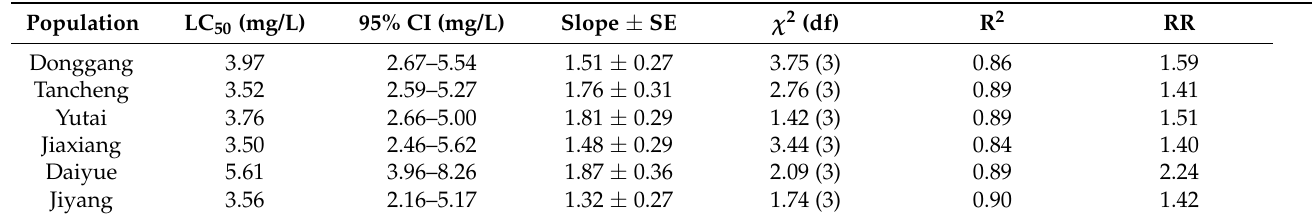
Table 8. Sensitivity to clothianidin in six L. striatellus populations in Shandong Province.